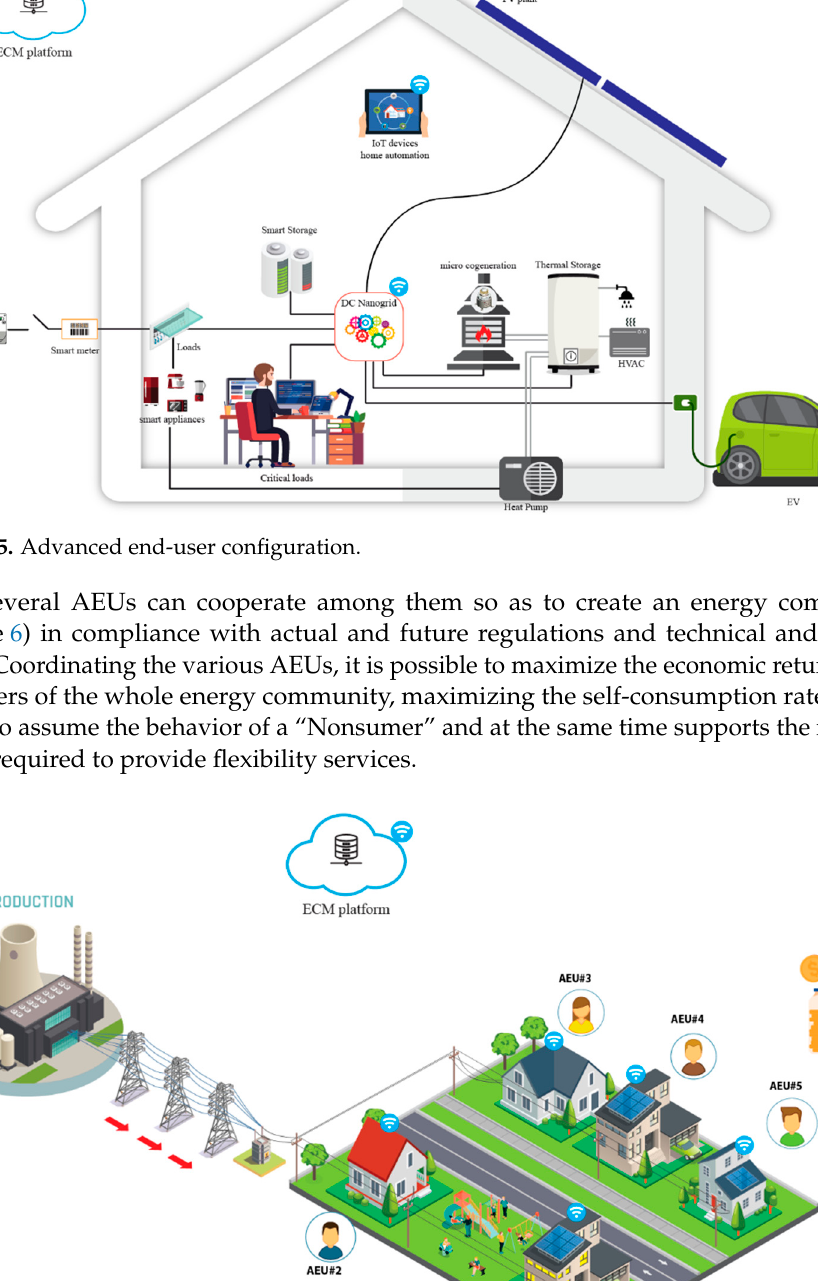
Figure 4. DCNG base module.